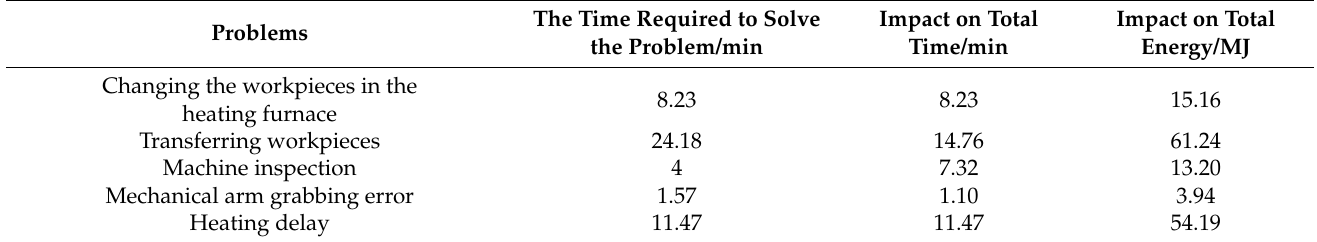
Table 7. Problems encountered in practical factory